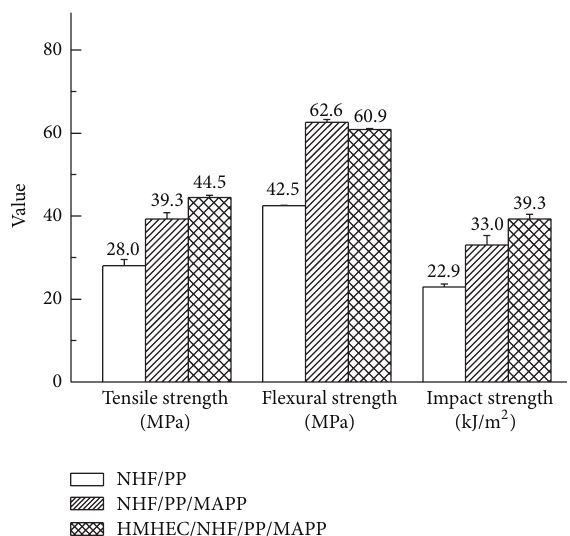
Figure 3: Influence of resin modification with MAPP and fibre treatment with HMHEC on the mechanical properties of the